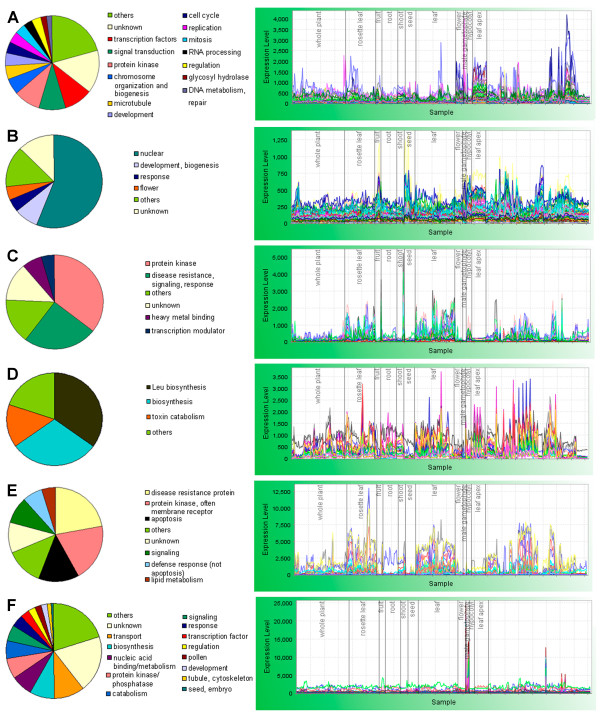
Regulons with developmental and metabolic functions. Regulon 4, cell division (for clarity, representative expression profiles of 200 randomly chosen genes are shown) (A); Regulon 20, nuclear regulation (B); Regulon 35, protein kinases, signaling and defense response (C); Regulon 69, glucosinolate biosynthesis (D); Regulon 25, defense response (E); and Regulon 1, pollen-specific (200 randomly chosen genes) (F). Pie charts are based on manual annotation. RNA profiles plotted using MetaOmGraph [24,124].